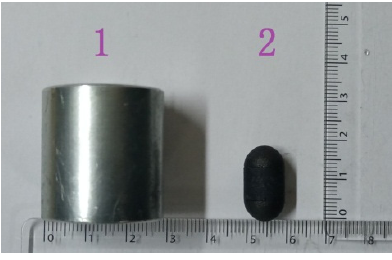
Figure 7. External permanent magnet and capsule robot. 1—External permanent magnet; 2—Capsule robot.